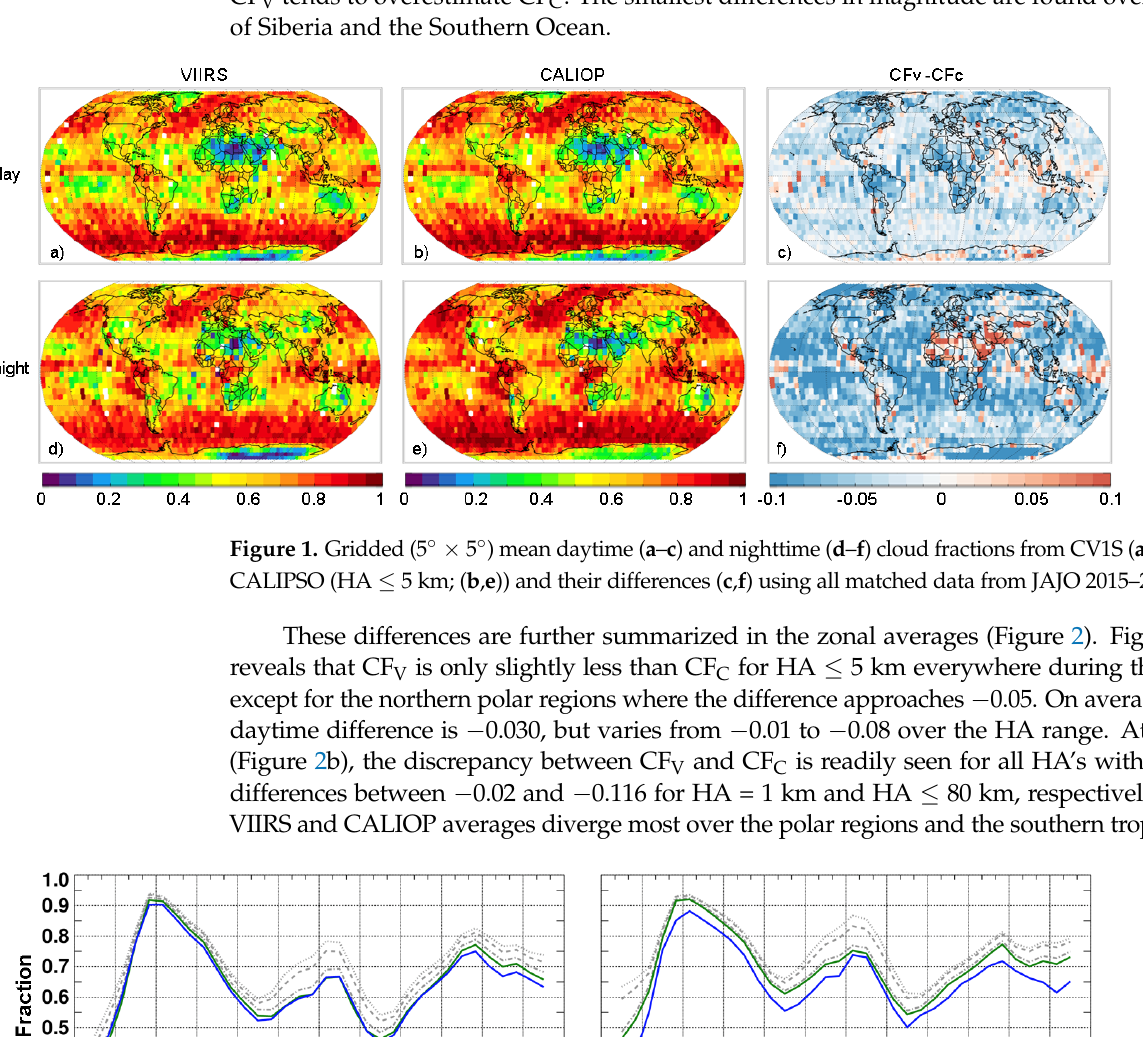
VIIRS and CALIOP averages diverge most over the polar regions and the southern tropics.